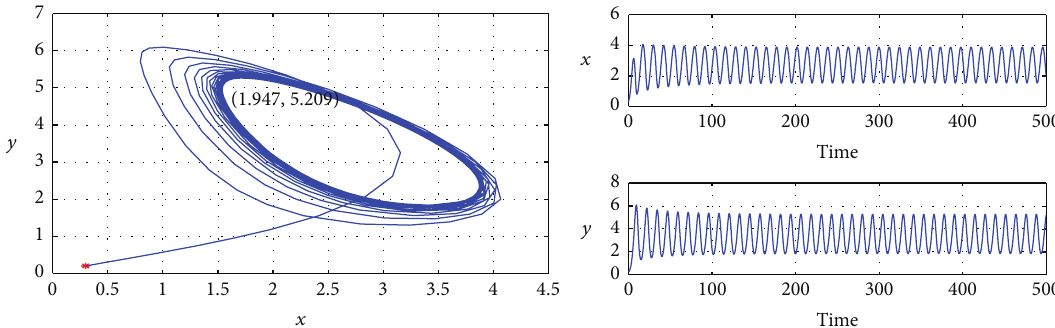
Figure 9: When 𝜏 = 2.9 > 𝜏 0 ≐ 2.8015 , the positive equilibrium 𝐸 ∗ of system (5) loses its stability and a Hopf bifurcations occurs.